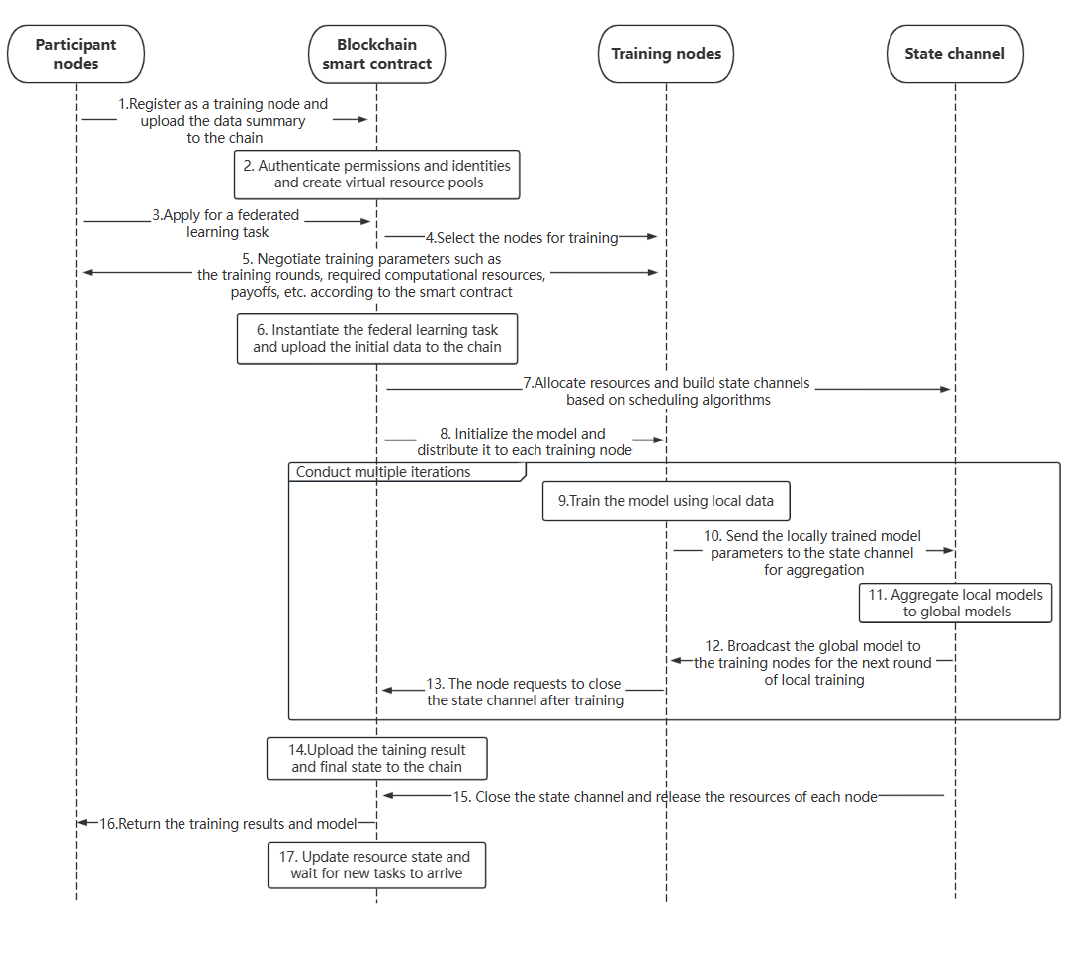
Figure 2. System Working Flow